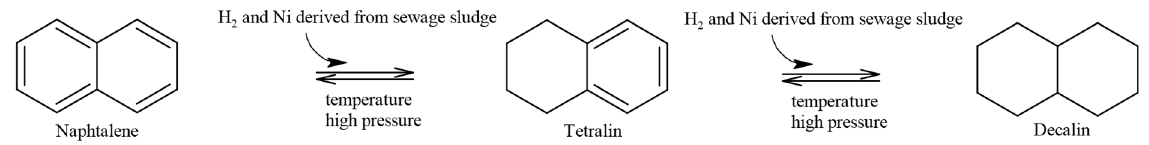
Figure 4. Transformation process of naphtalene into decalin.